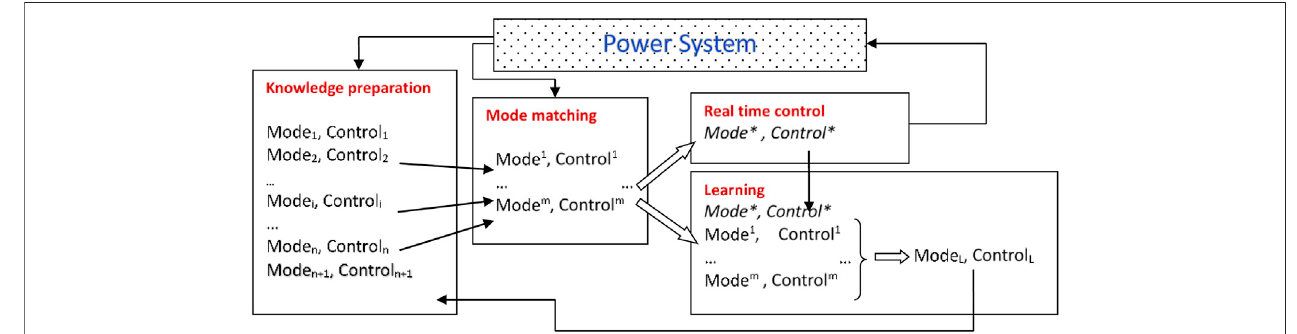
FIGURE 2 | Functional structure of